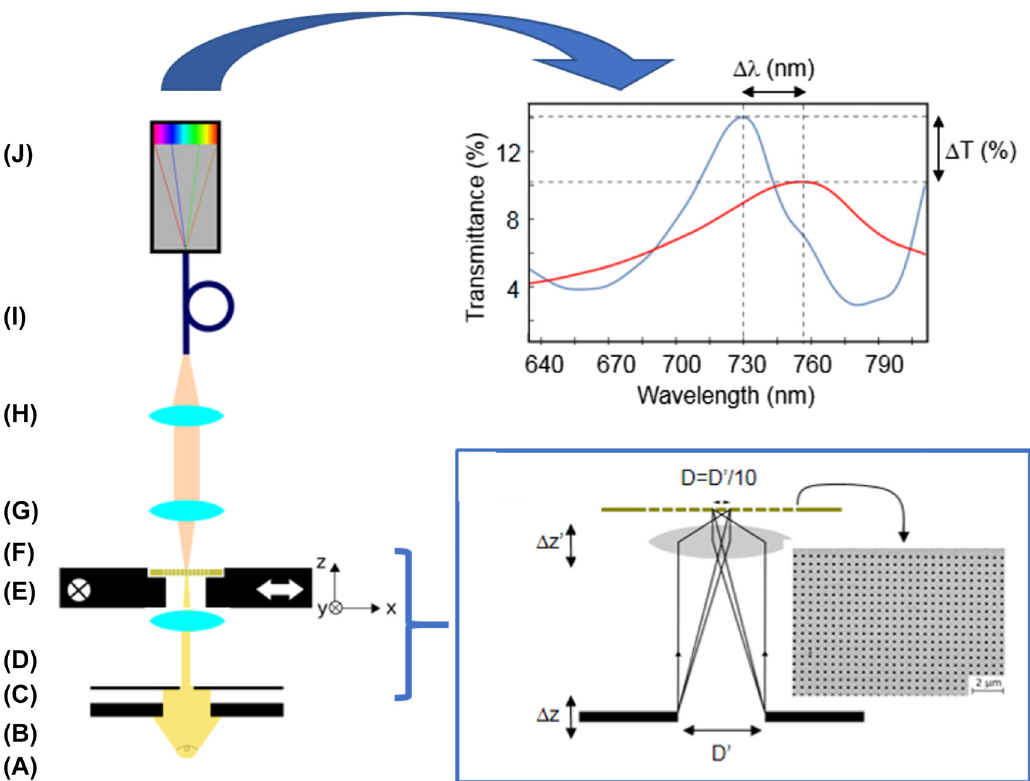
Figure 1: Left : Nanohole array sensor-based optical system proposed in this work. (A) The light source is a 100 W halogen lamp; (B) Field stop: the minimum fi eld stop diameter is 1.5 mm; (C) Field pinhole: it is a geometric tailorablepinhole;(D)Thecondenserisanachromaticandaplanaticlenswith0.5numericalapertureandobjectdistanceequalto 1.6mm;(E) Thesample-holderisamotorizedstagefordisplacementsassmallas100nmalongboth X and Y directions.Itisgovernedbymeansofaprior- Scan III controller; (F) The nanohole patterned sensor; (G) The objective lens is a 20 × bright fi eld lens; (H) The collecting lens is a 4.5 mm focal distancelens;(I)Theoptical fi ber(OceanOptics)hasa200 μ mcore,optimizedforitsuseintheUV – visiblespectralregion;(J)AndorShamrock spectrograph operating with a 300 μ m entrance slit and coupled to an Andor IDUS CCD camera with an integration time of 0.1 s. Top-right : An example of the output of the spectrograph. Δ λ corresponds to the spectral shift when a cell is located on the biosensor area and Δ T to the changeinthetransmission. Bottom-right :Detailoftheensemble(C) – (E)wherethecondenserlensproducesanimageofthediaphragm(C)on the sensor chip with a magni fi cation 1/10.